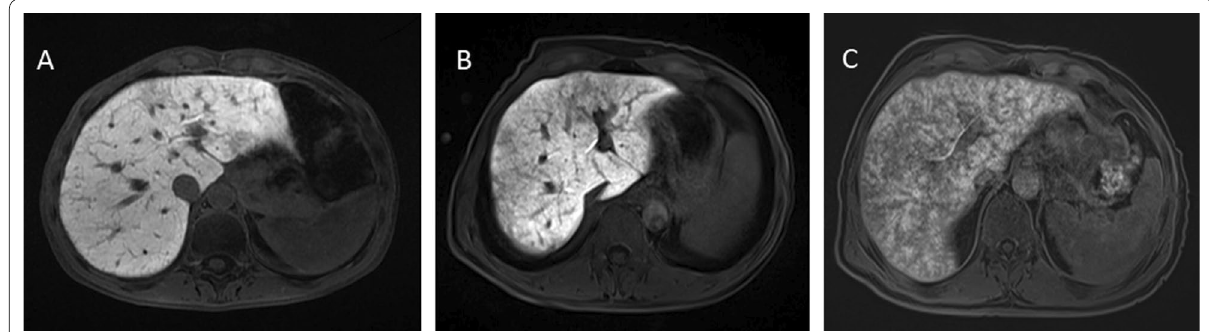
Fig. 1 Classification of SOS severity according to the extent of reticular hypointensity on the hepatobiliary phase images; ‘mild’ ( A ) if reticular hypointensity are less than 20% of the liver parenchyma, ‘moderate’ ( B ) if 20–50%, and more than 50% ‘advance’ ( C ) grade